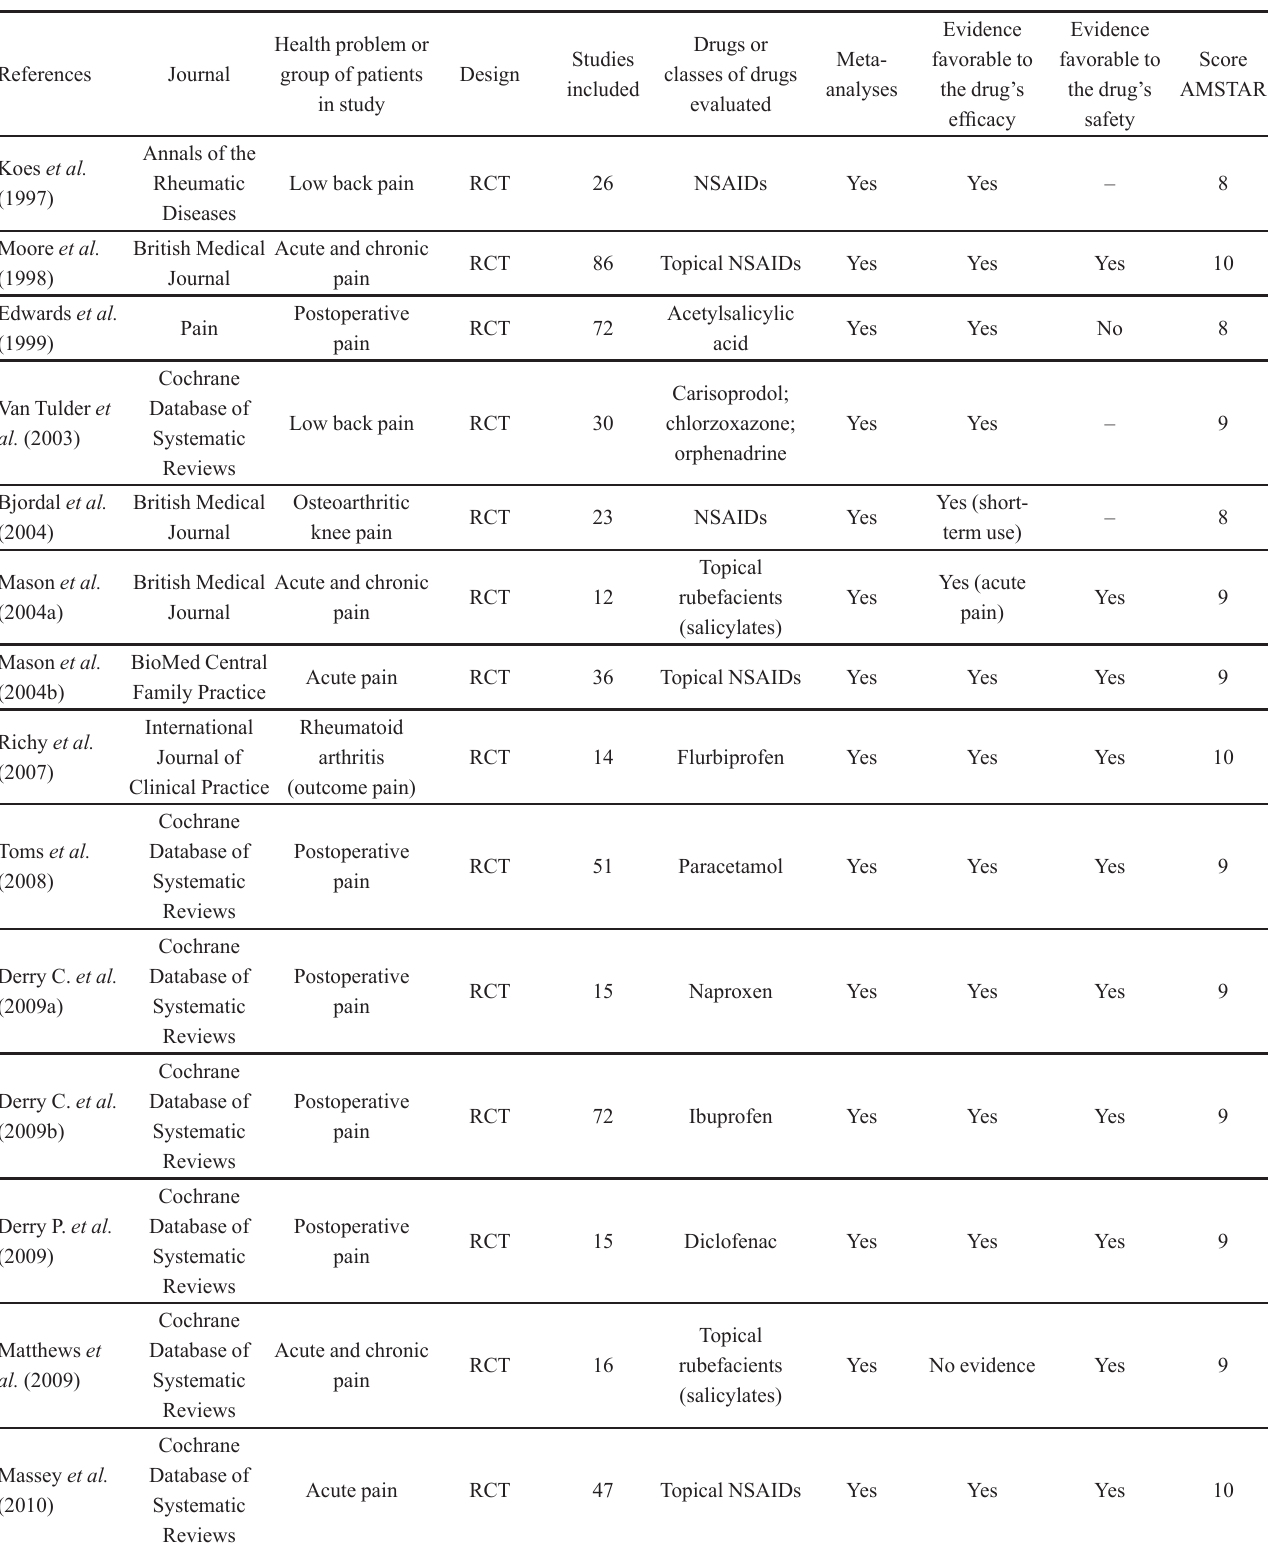
TABLE I - Main characteristics of systematic reviews on OTC